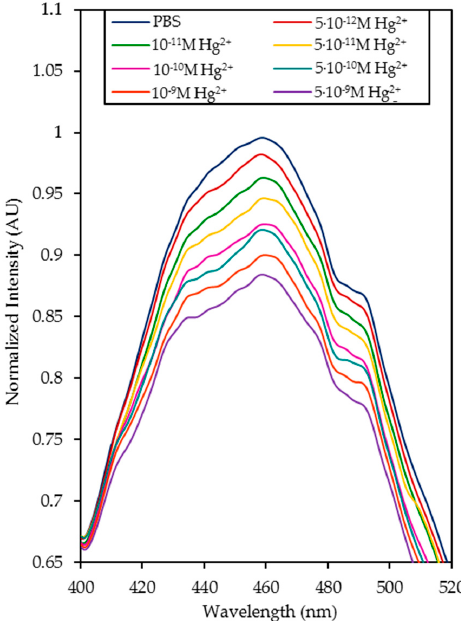
Figure 5. Normalized luminescence intensity for different Hg 2+ concentrations: 0 M, 5 × 10 − 12 M, 10 − 11 M,